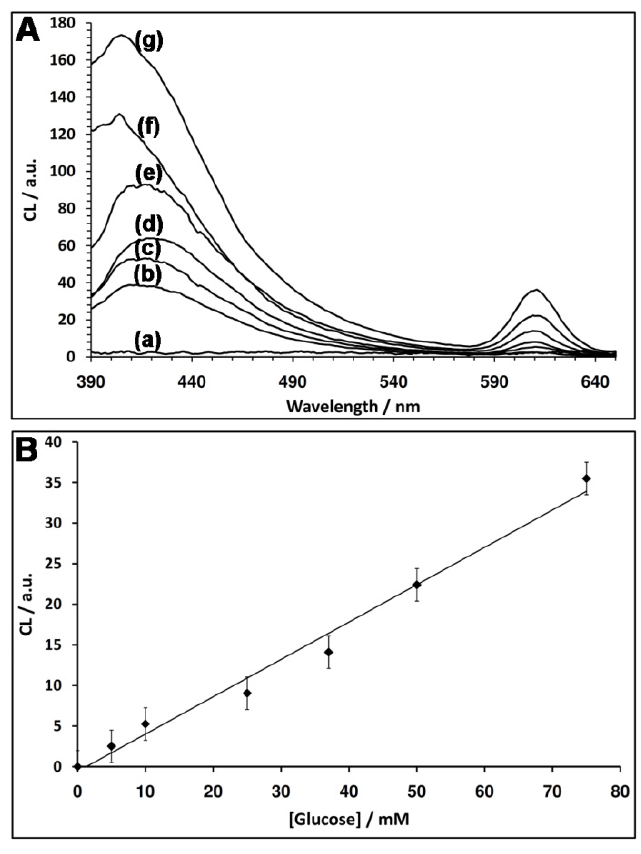
Figure 4. (A) Luminescence spectrum corresponding to the CRET signal of the QDs at λ = 610 nm in the absence of glucose, curve (a), and in the presence of different concentrations of glucose: (b) 5 mM (c) 10 mM (d) 25 mM (e) 37 mM (f) 50 mM (g) 75 mM; (B) Calibration curve corresponding to the increase in the CRET signal at λ = 610 nm. Each data point is the average of N = 3 individual measurements. The error bars indicate the standard